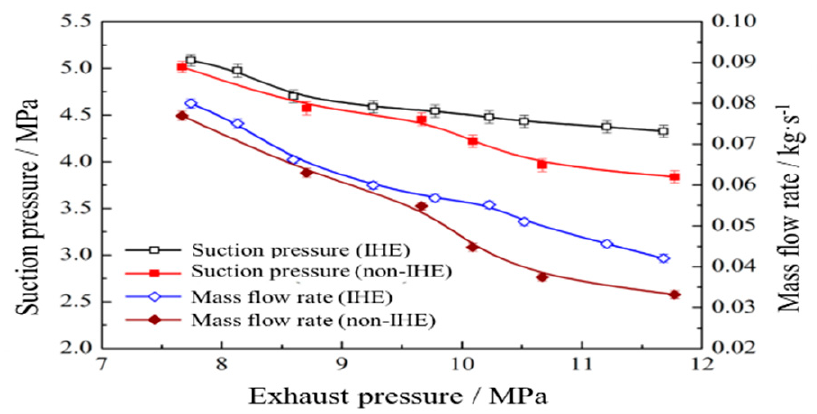
Figure 2. Variation of suction pressure and CO 2 mass